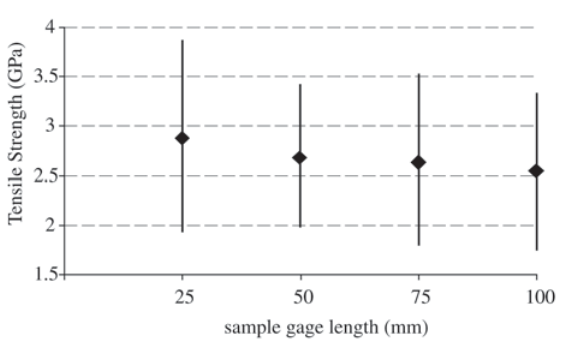
Figure 5. Tensile strength as a function of sample gage length for carbon